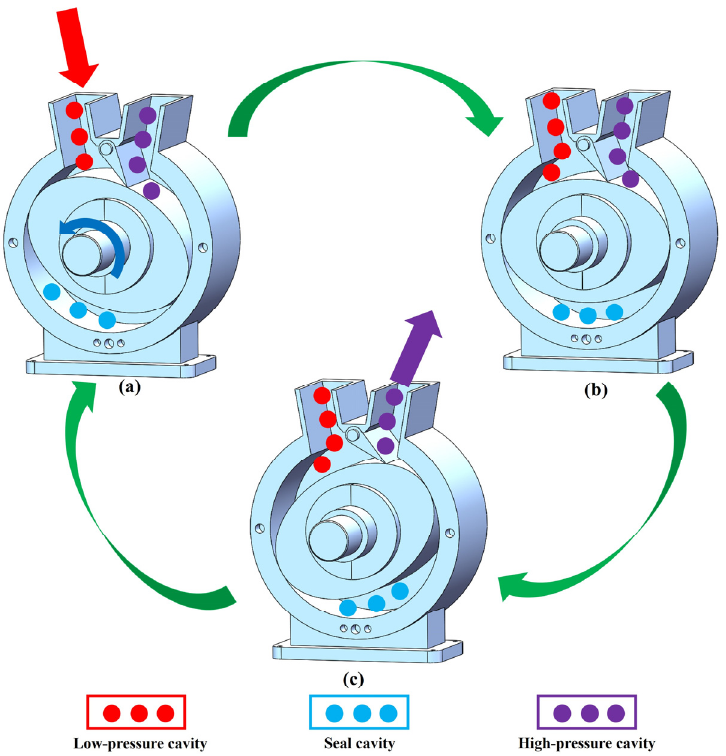
Figure 2. Working principle of the ERSP. ( a ) Admission state ( b ) intermediate state ( c ) exhaust state.